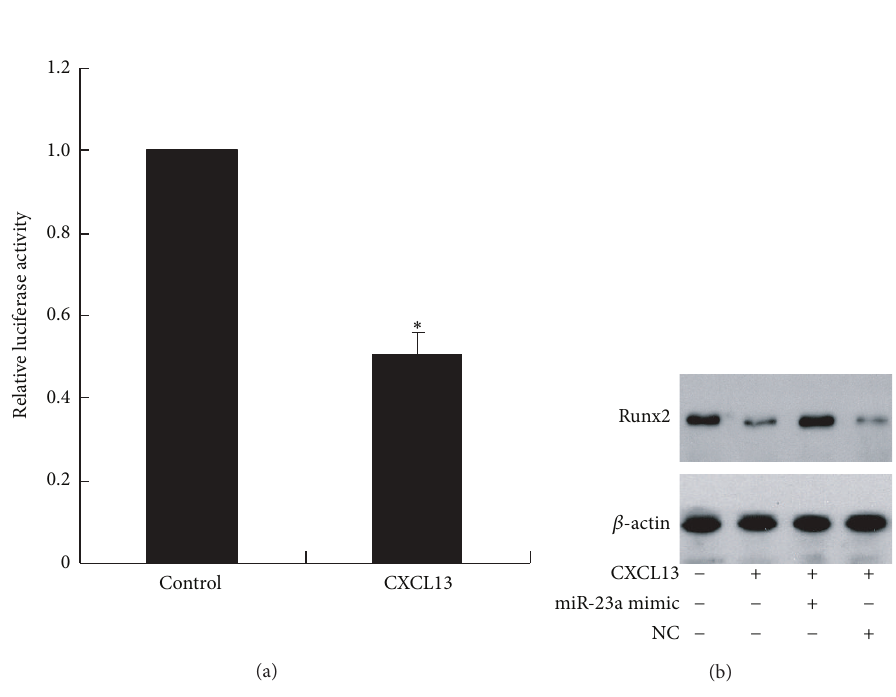
Figure 4: Regulation of Runx2 expression by miR-23a in BMSCs. (a) Runx2 3 󸀠 UTR luciferase assay. (b) Expression of Runx2 in cells transfected with a miR-23a mimic. All values represent means ± SD ( 𝑛 = 3 ). ∗ 𝑃 < 0.05 compared with control groups.